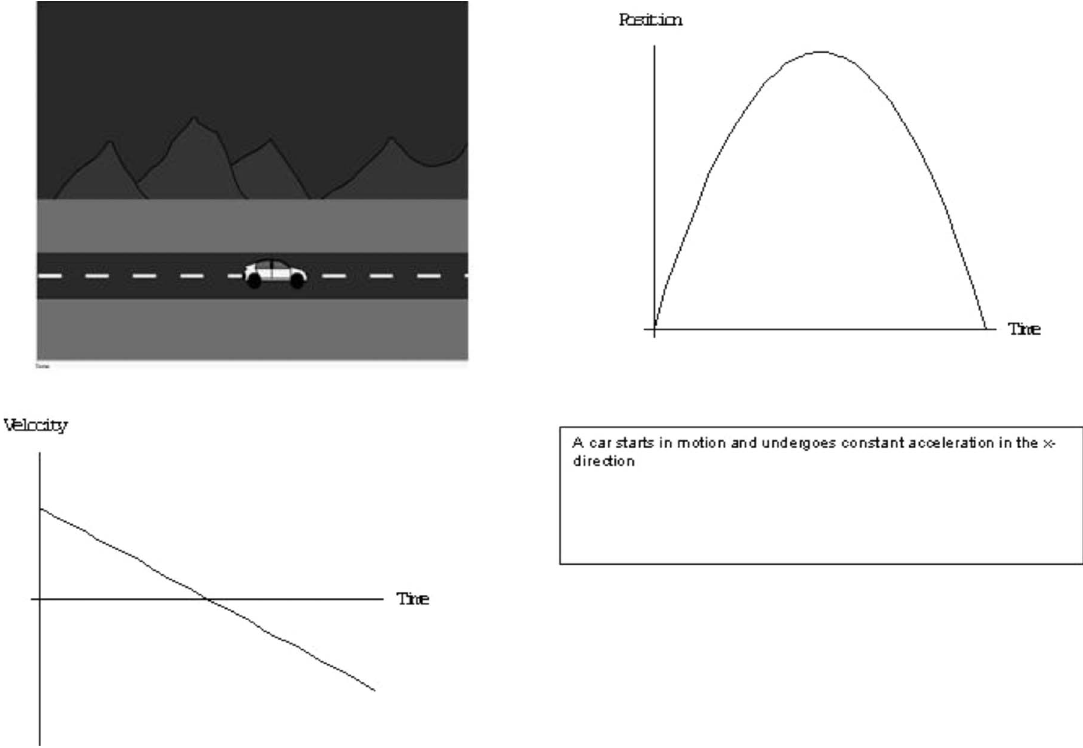
FIG. 1. Four representations of the motion of a car (cid:1) a snapshot from a Flash movie, a graph of position versus time, a graph of velocity versus time, and a written description (cid:2) . The students interviewed were required to make sets of these representations that all corresponded to the same